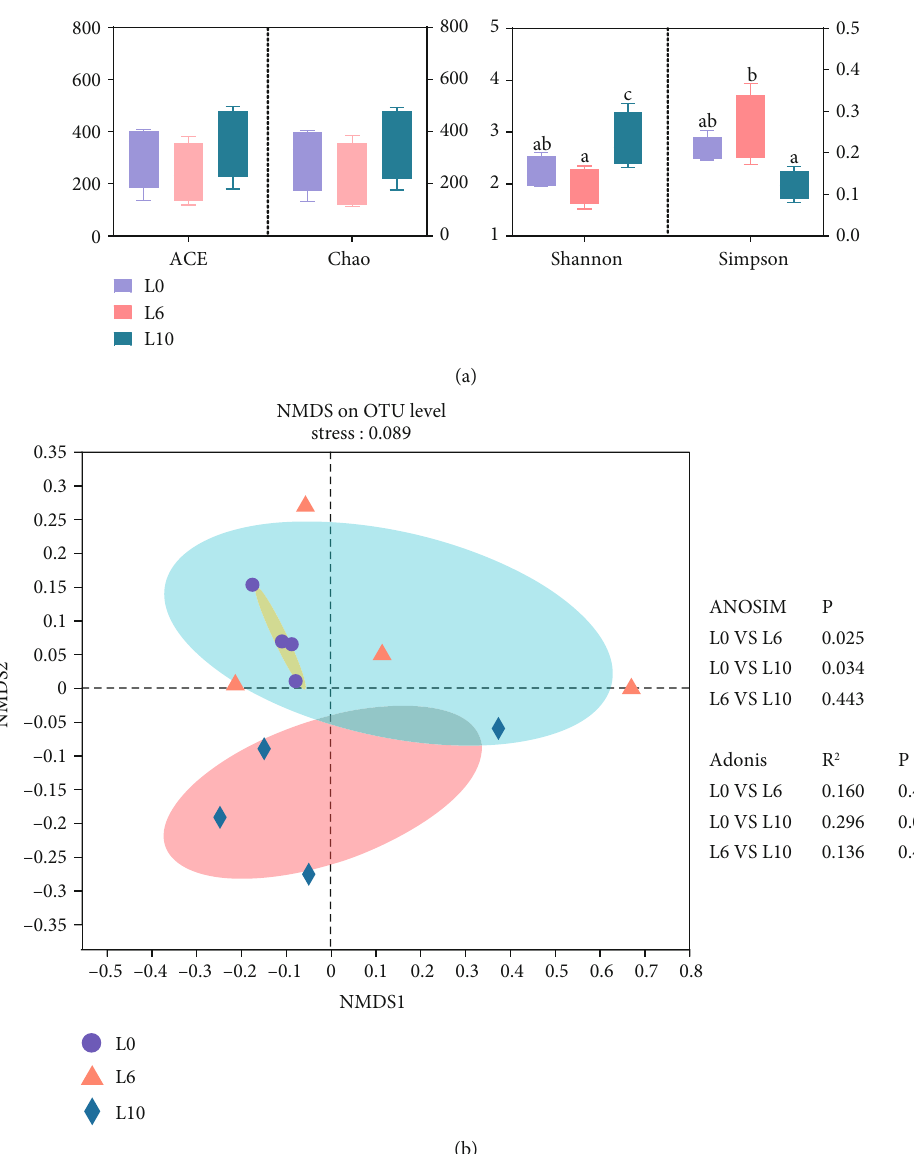
Figure 7: Diversity of the bacterial community in C. quadricarinatus fed diets with di ff erent lipid levels. (a) Alpha diversity. (b) Beta diversity. All data are expressed as the mean ± SE ( n = 4 ), and P < 0 : 05 was considered signi fi cantly di ff